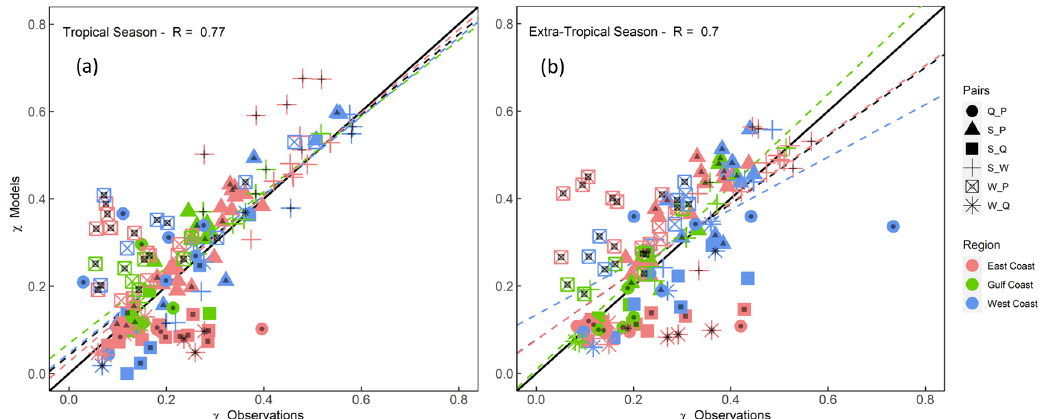
Figure 11. Scatterplot comparing extremal (tail) dependence (for q = 0 . 9) derived using observations ( x axis) and models ( y axis) for tropi- cal (a) and extra-tropical (b) seasons, using a daily time series of both variables. Colours denote the location (separated into East, Gulf, and West coasts), and markers represent the different variable pairs. Black dots on markers indicate significant difference in the tail dependence structure between observations and models according to the KL divergence. Dashed lines show linear regression fits corresponding to all data points (black) and for different subsets according to locations (coloured as outlined in the